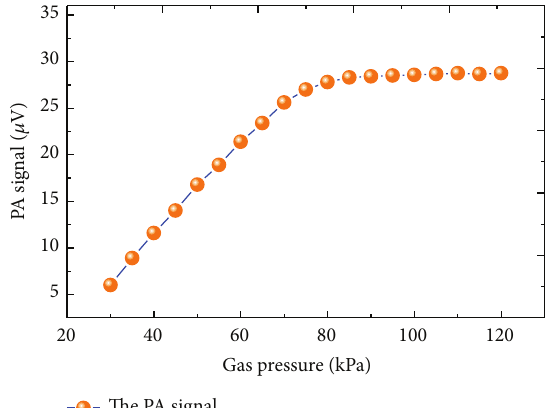
Figure 6: The PA signal versus CO gas pressure ranging from 0.03 to 0.12 MPa.